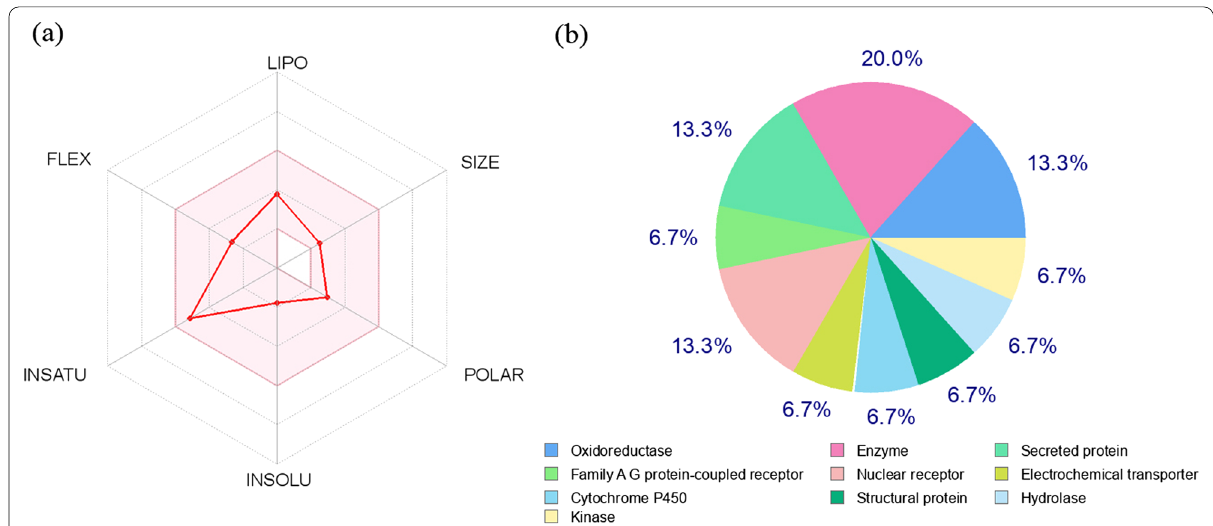
Fig. 3 a The bioavailability radar chart of zingerone structure obtained from SwissADME prediction, b the small molecule protein targets for zingerone structure obtained from SwissTargetPrediction web